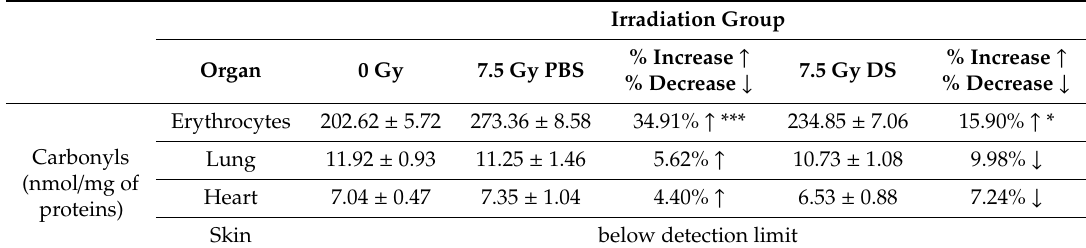
Table 6. Carbonyls in erythrocytes, lung, heart and skin of mice irradiated by PBS or DS proton beams in the plateau phase of the Bragg